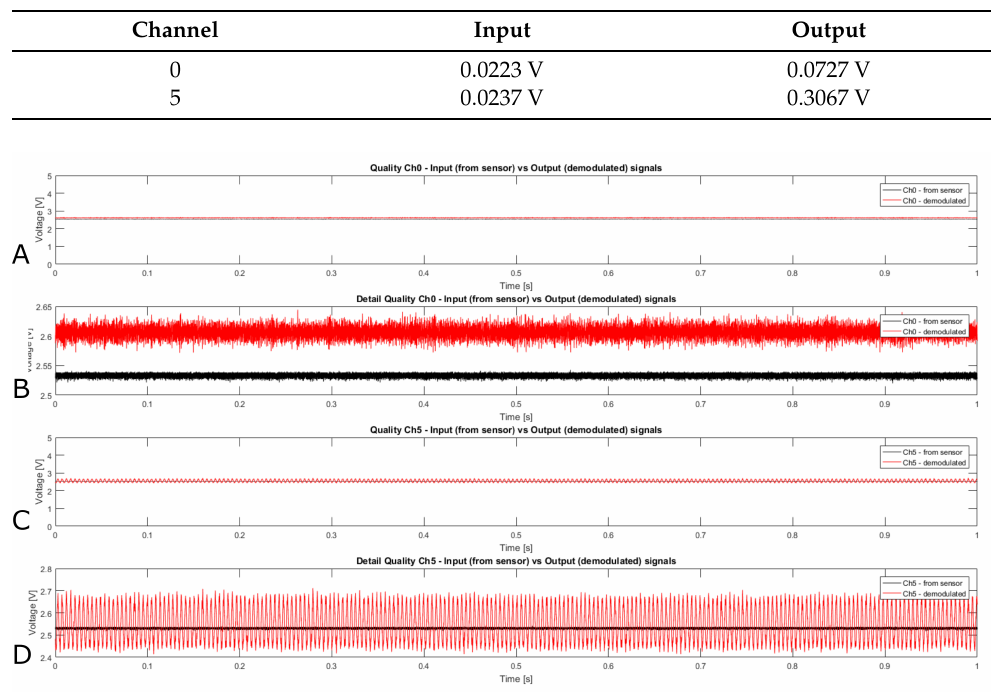
Figure 5. ( A ) Channel 0 Input signal (measured directly from sensor) and output reconstruction after demodulation without any adjustment. ( B ) Plot detail of A. ( C ) Channel 5 Input signal (measured directly from sensor) and output reconstruction after demodulation without any adjustment. ( D ) Plot detail of